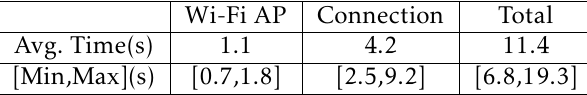
Table 2. Performance of